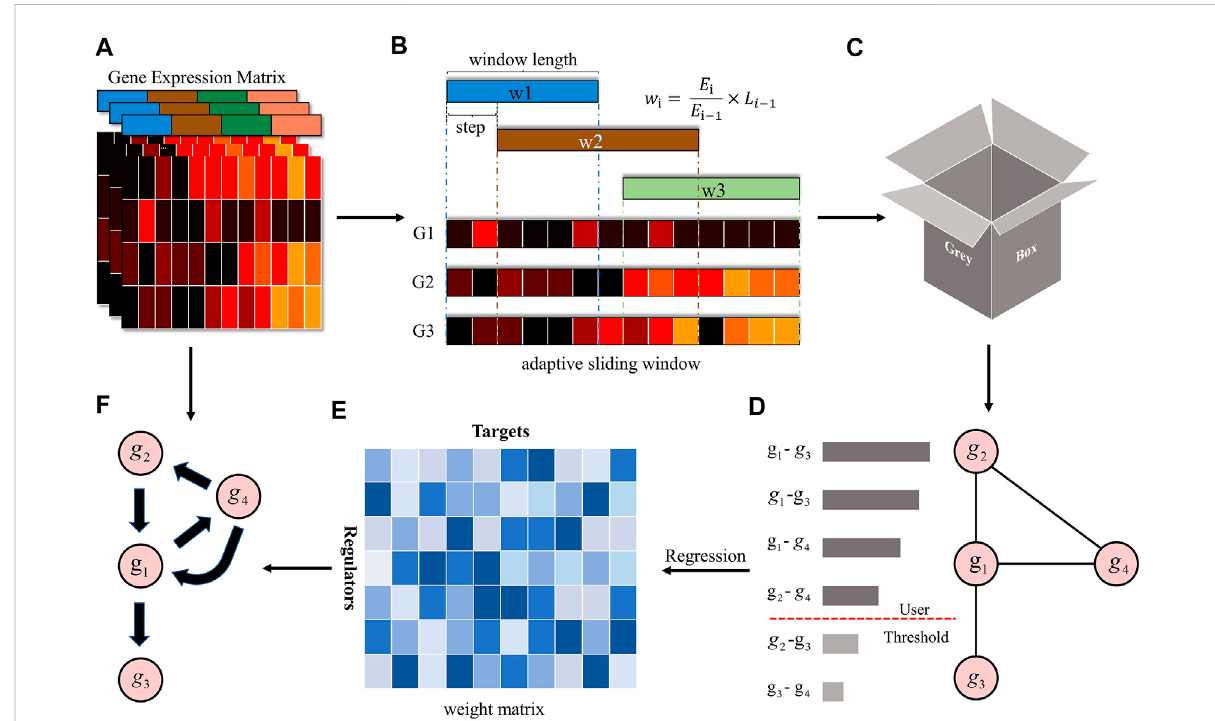
FIGURE 1 The overview of the GreyNet framework. (A) is the expression matrix of genes. (B,C) is the procedure of dynamic grey association. The window lengthisautomaticallyadjustedbyinformationentropy(IE).We fi rstlysamplethetimepointsbytheslidingwindow.Then,weinputthesampleddata into grey relational analysis to get the dynamic grey association coef fi cient as (D) . (E) is the weight matrix generated by regression methods that transform the dynamic grey association to causal directional regulatory link as (F)